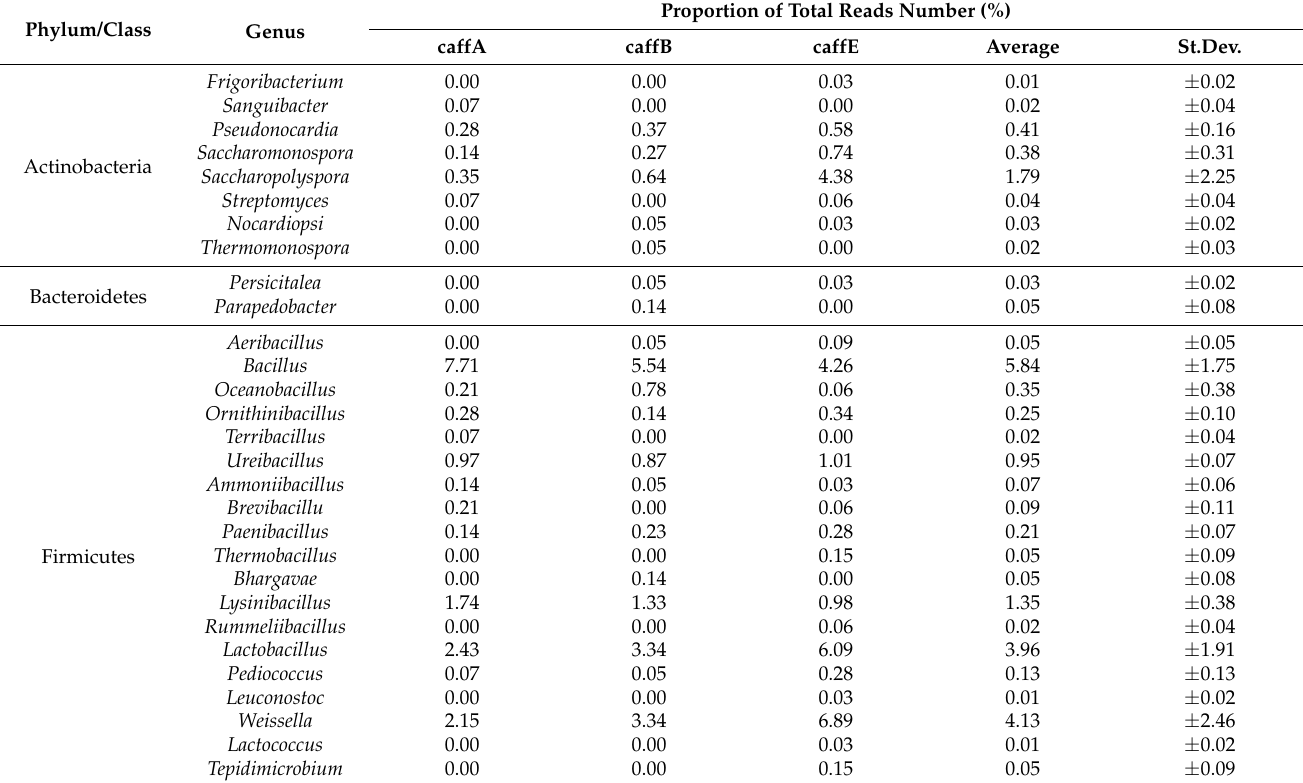
Table 3. Genera retrieved within the bacterial